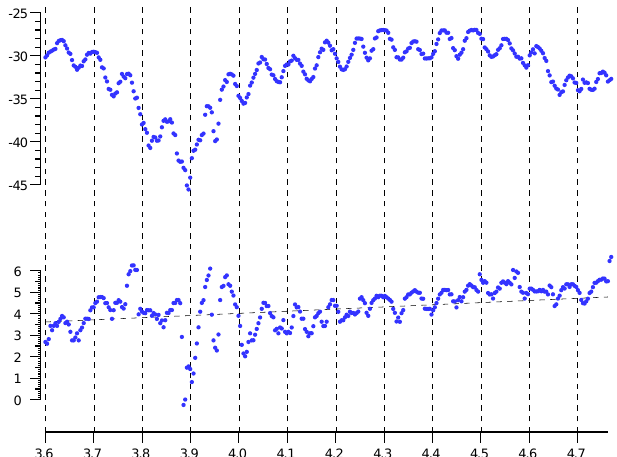
Figure 5. Upper plot: signal strength (RSS) in dBm, Lower plot: reported distance in meters. Horizontal axis: actual position in meters. Note undulations with wavelength somewhere between about half the wavelength and the full wavelength of the (2.4GHz) electromagnetic wave. (There is also an overall trend in RSS, probably due to destructive interference between the direct signal and a reflection off the concrete floor about 1.2 m below the line connecting the intiator to the